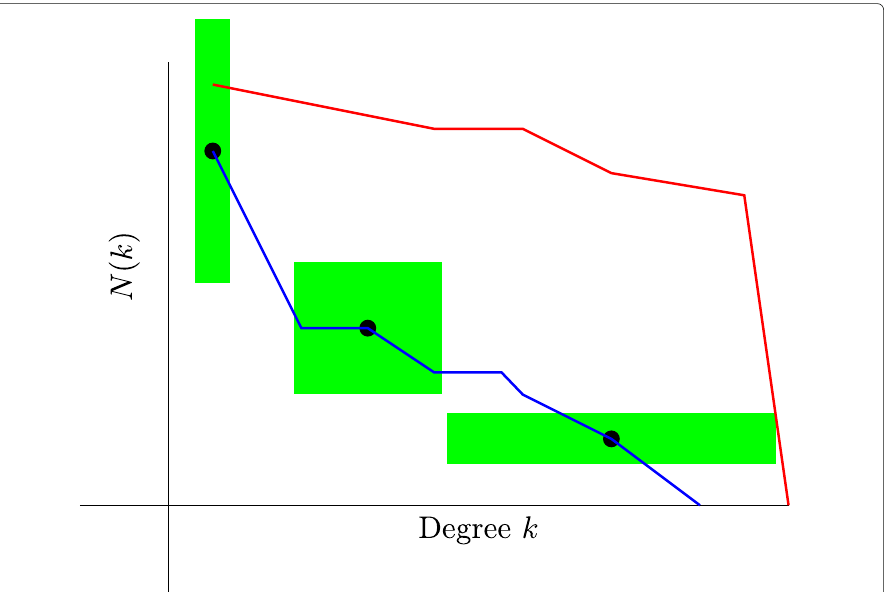
Fig. 1 An illustration of the RH equivalent of an (cid:3) -ball (in green) on one graph ccdh (in blue) compared with another (in red) at different